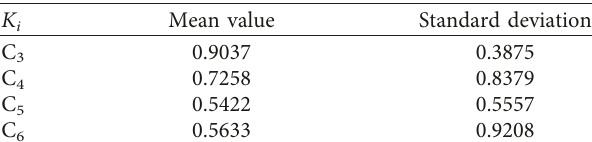
Table 3: Mean value and standard deviation for uncorrelated equilibrium constants.